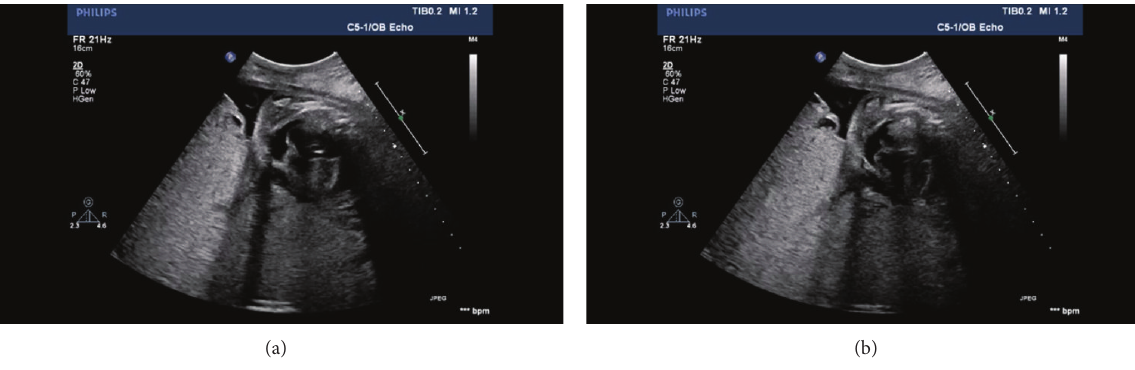
Figure 3: Fetal echocardiographic appearance of dilated coronary sinus.